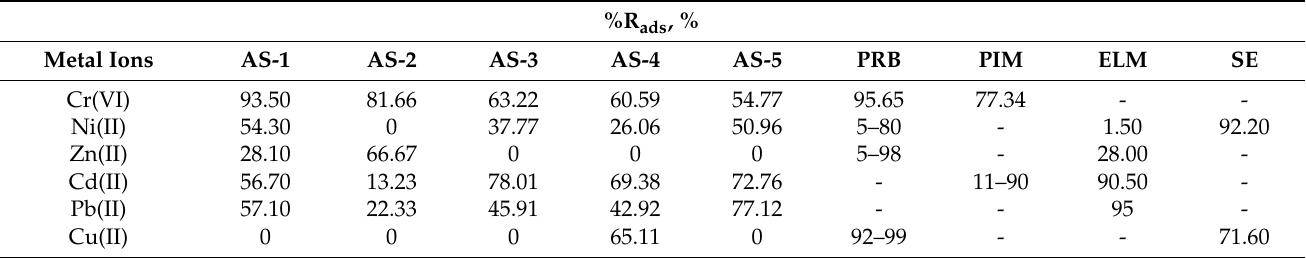
Table 3. Comparison of the sorption efficiencies of heavy metals on AS-1 – AS-5 with the literature data [%]